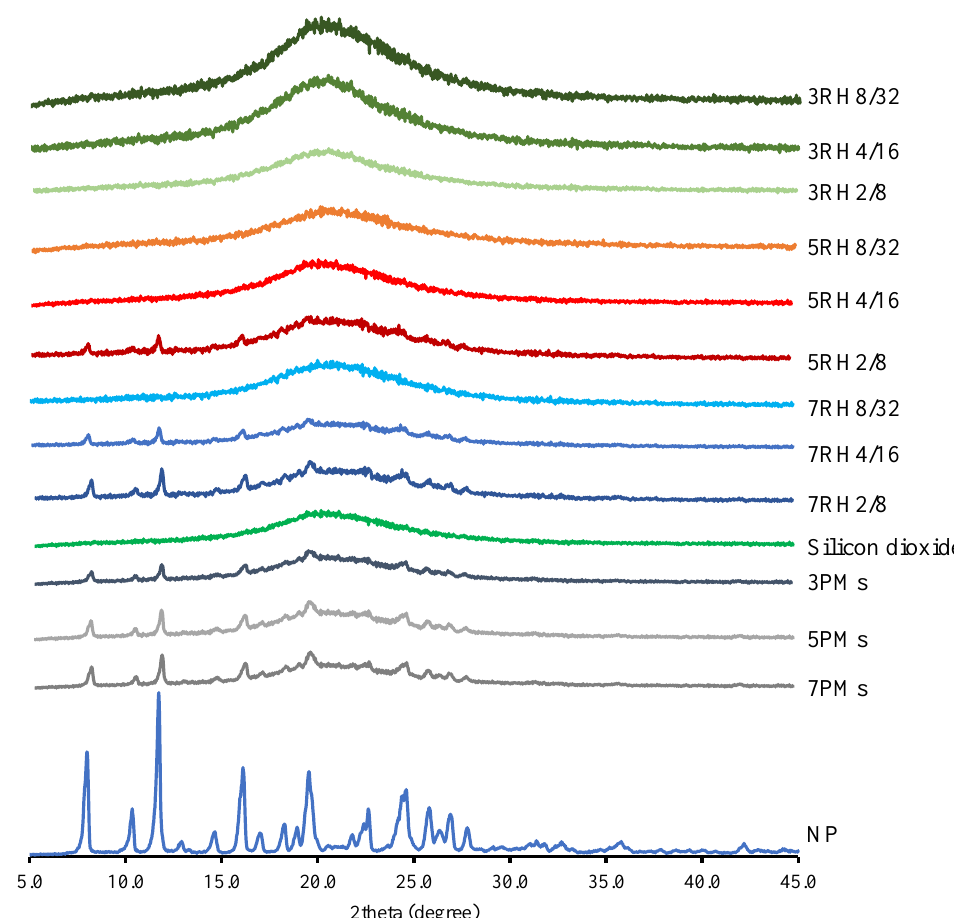
Figure 3. Powder X-ray diffraction patterns of the dry MIPEs and NP powder. The 3PMs, 5PMs, and 7PMs were PMs of 8% surfactant and 32% oil, with NP contents of 0.3%, 0.5%, and 0.7%,